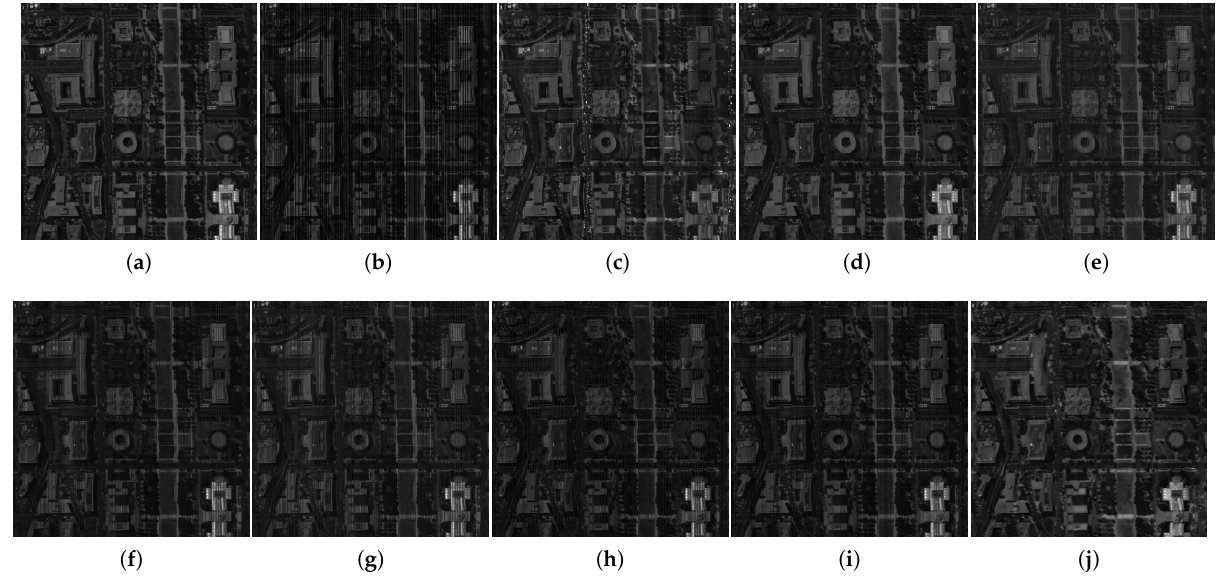
Figure 4. Corrected Washington DC Mall images for band 42. ( a ) Original image. ( b ) Degraded image. Images corrected by ( c ) MM, ( d ) ASSTV, ( e ) LRSID, ( f ) that of reference [43], ( g ) PADMM,